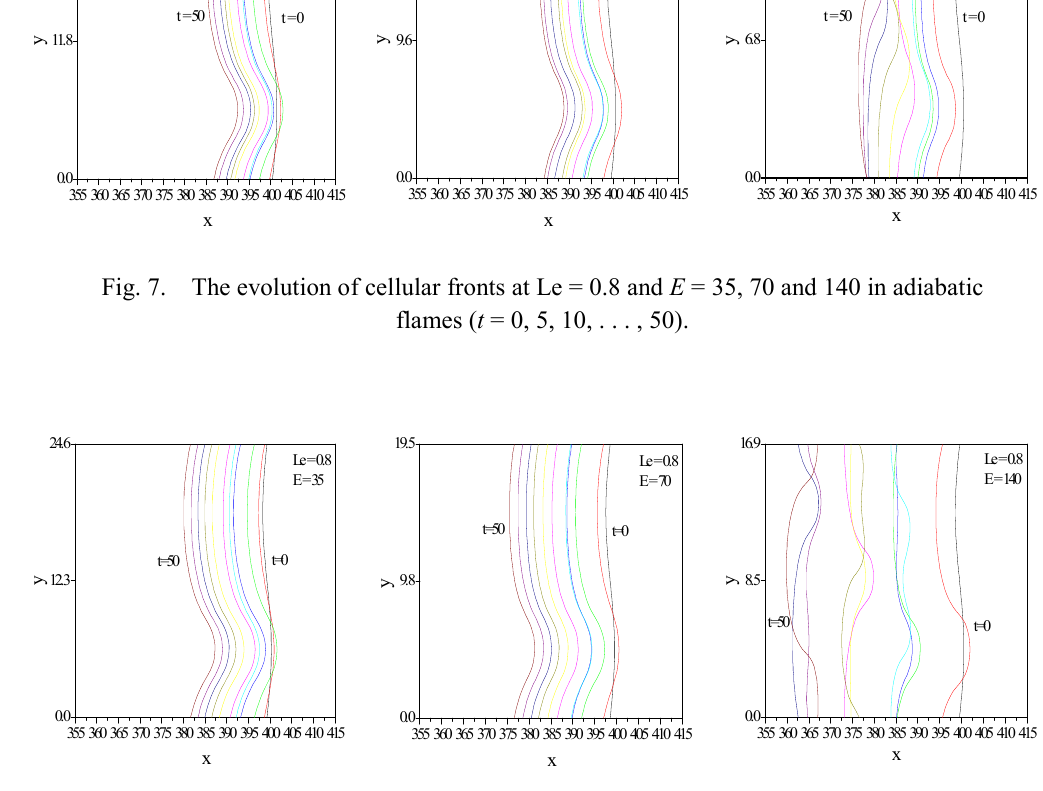
Fig. 8. The evolution of cellular fronts at Le = 0.8 and E = 35, 70 and 140 in non-adiabatic flames ( t = 0, 5, 10, . . . ,